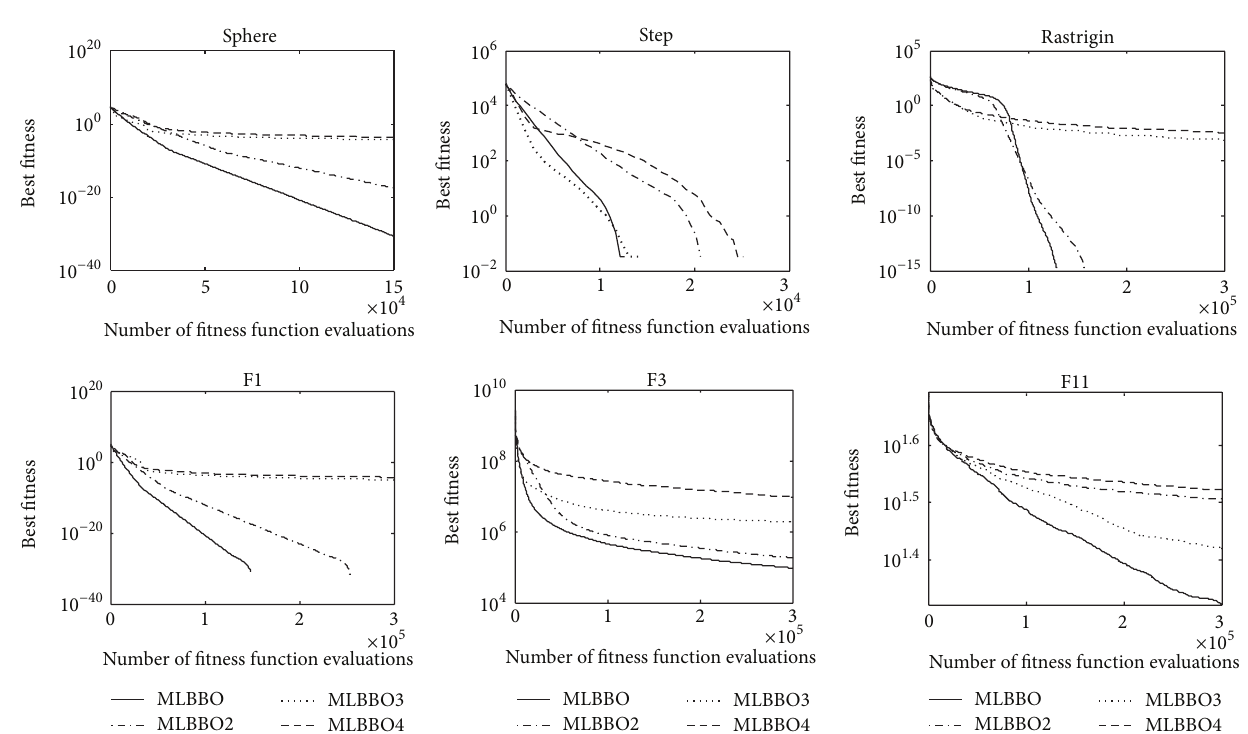
Figure 8: Mean fitness curves to analyze operators of MLBBO for selected functions f1, f6, f9, F1, F3, and